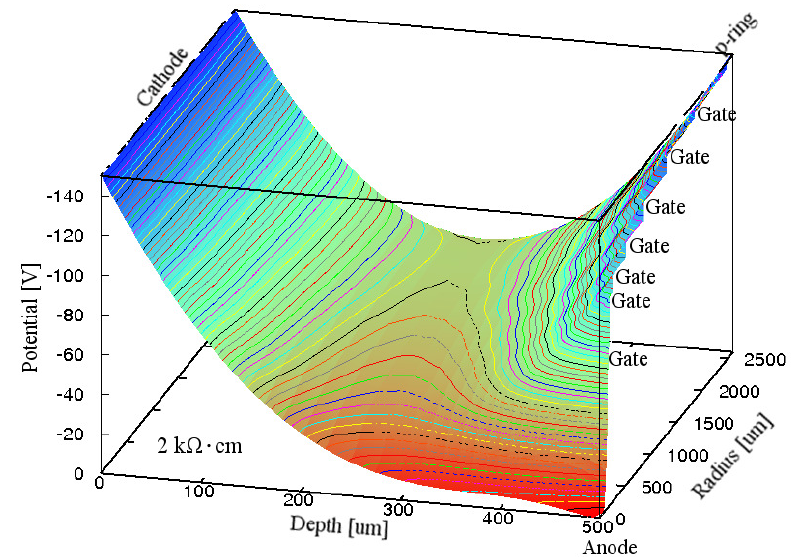
Figure 6. Simulated electric potential distribution in the Si substrate inside the p-ring of a 0 . 5 -mm-thick GSDD with R of 3 . 5 mm and ρ of 2 k Ω · cm for Gate C. A reverse bias chip Si voltage of − 150 V was applied to the cathode, p-ring, and seven gates. Equipotential lines are shown at 2 . 5 V